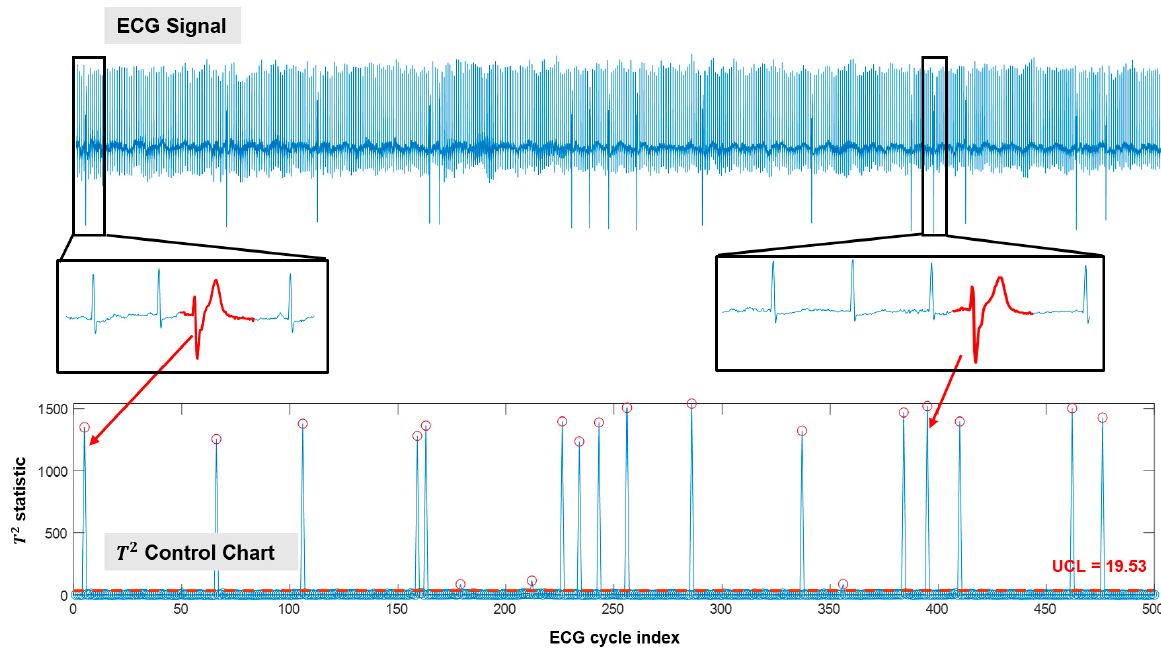
Figure 7. Cycle-based monitoring and anomaly detection for patient s20081 in the PhysioNet long-term ST dataset (only 500 cycles are demonstrated).